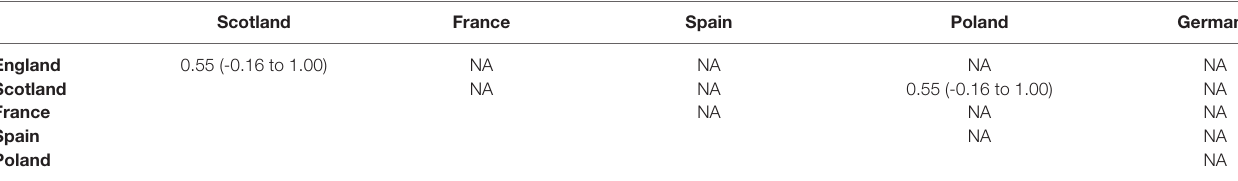
TABLE 8 | Agreement in recommendations between countries for metabolic